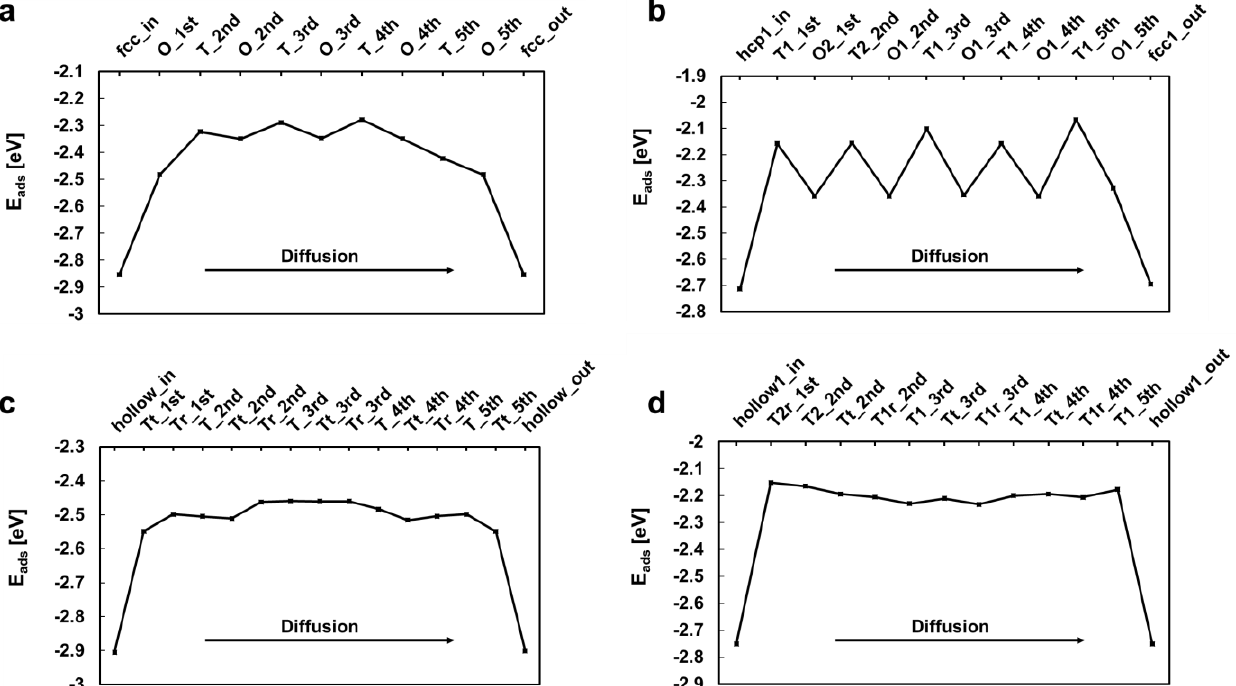
Figure 11. Variations of H binding energy as an H atom migrates through the Pd and PdCu